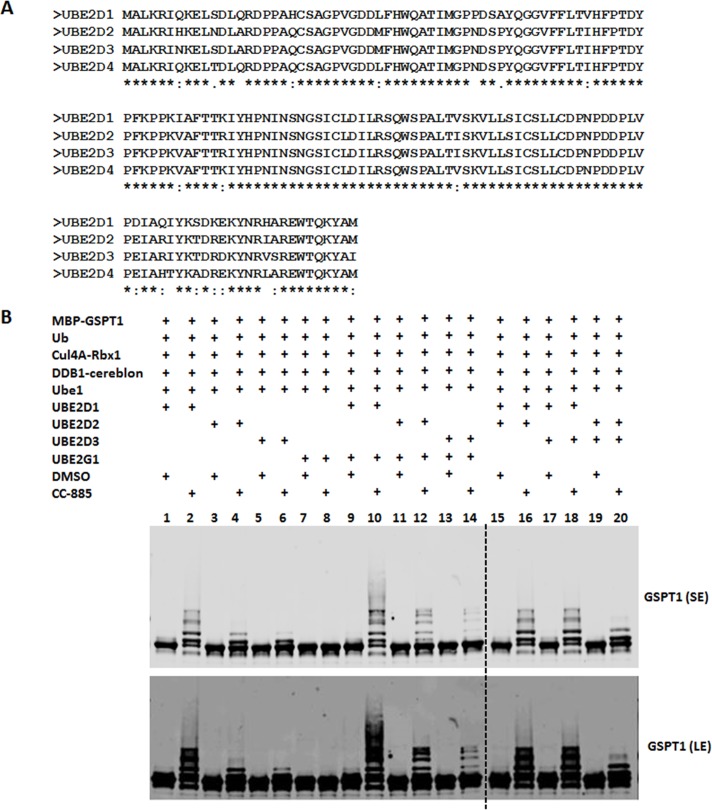
UBE2D family proteins redundantly promote the ubiquitination of GSPT1.(A) Sequence alignment of human UBE2D family proteins using Clustal W 2.1. Note that the amino acid sequence identity among all four family proteins is close to 90%. (B) In vitro ubiquitination of GSPT1 MBP fusion protein by recombinant CRL4CRBN complex in the presence of UBE2G1, UBE2D1, UBE2D2, or UBE2D3, alone or in combination. Recombinant protein products as indicated were incubated with or without 80 µM CC-885 in the ubiquitination assay buffer at 30°C for 2 hr, and then analyzed by immunoblotting. SE, short exposure; LE, long exposure. Result is representative of three independent experiments.